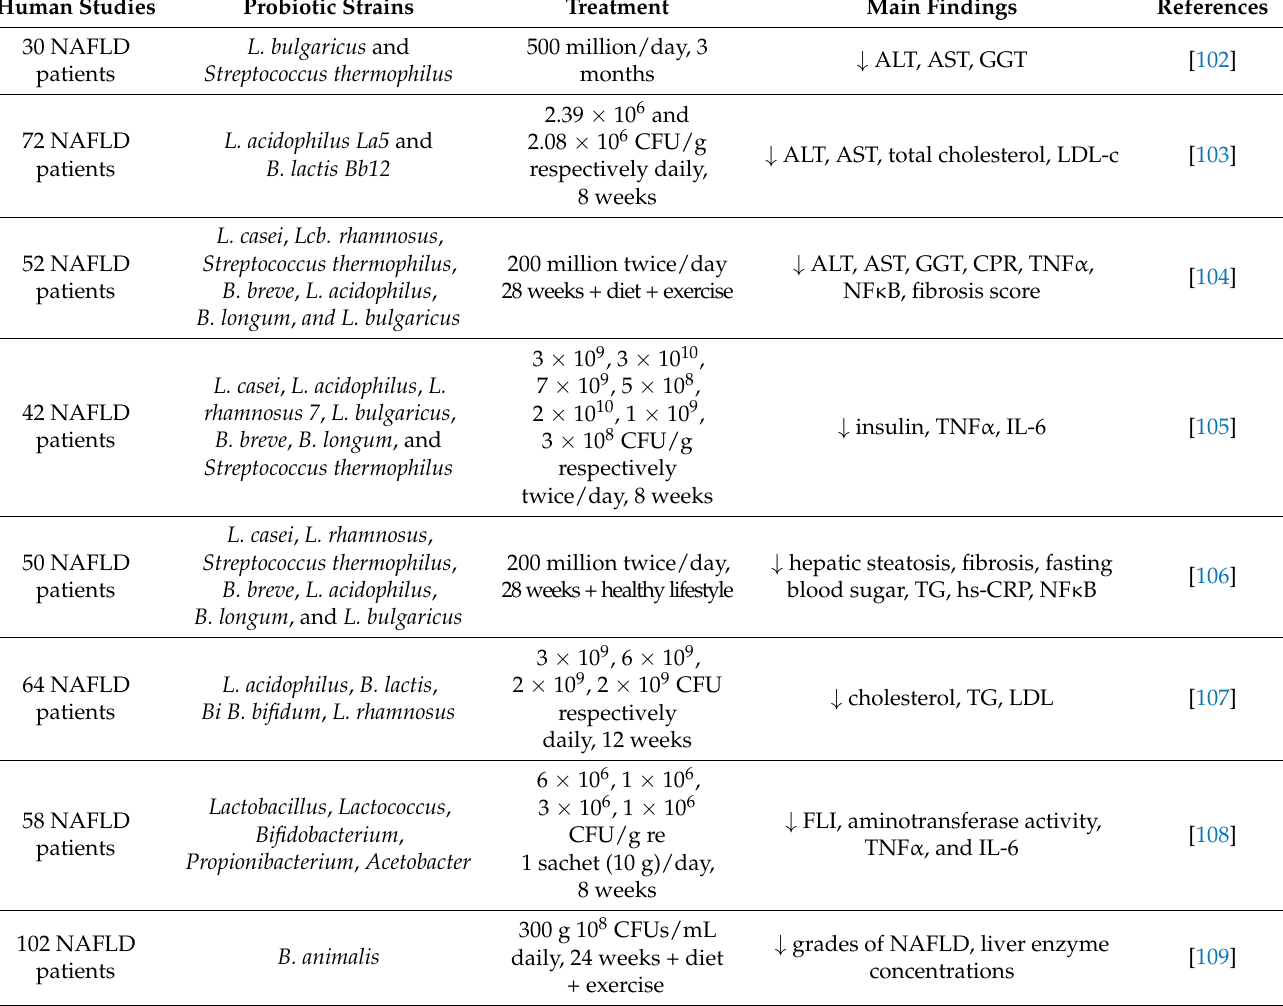
Table 2. Main results reported for the effects of probiotics in NAFLD